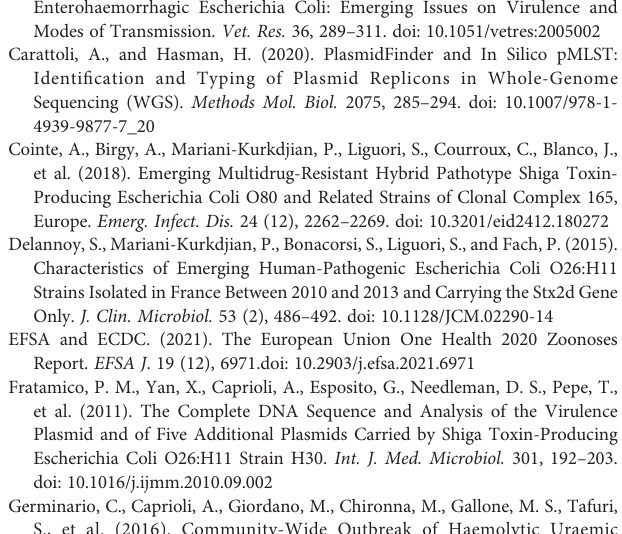
Supplementary Table 1 | For each tested strain the table includes: the statistics of the assembled contigs, details on sequencing technology used, region and year of isolation, and variables results used in HCPC analysis (for qualitative detection: 1 = presence; 0 = absence). The last column contains the cluster attributed to each strain through HCPC